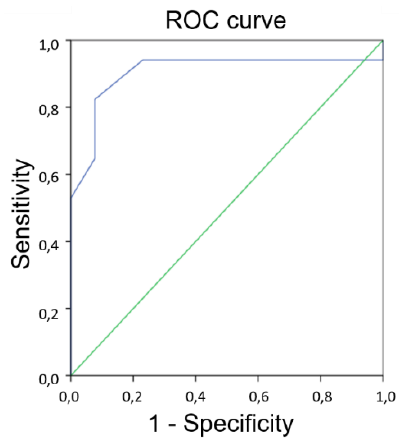
Figure 4. ROC curve for discrimination between UWS and MCS patients. AUC = 90.5%, p = 0.000056. Spearman correlation analysis showed significant negative correlation between CRS-R score and DOC-MRIDS score with Spearman ρ = − 0.68, p = 0.01 (Figure 5). There also were significant ( p < 0.05) negative correlations between CRS-R score and diffuse cortical atrophy (Spearman ρ = − 0.6), leukoaraiosis (Spearman ρ = − 0.62), brainstem and/or thalamus degeneration (Spearman ρ = − 0.51) and corpus callosum degeneration (Spearman ρ = − 0.58). CRS-R auditory, visual, motor and communication domains significantly ( p < 0.05) correlated with the same structural parameters (Spearman ρ ranged from − 0.5 to − 0.65).